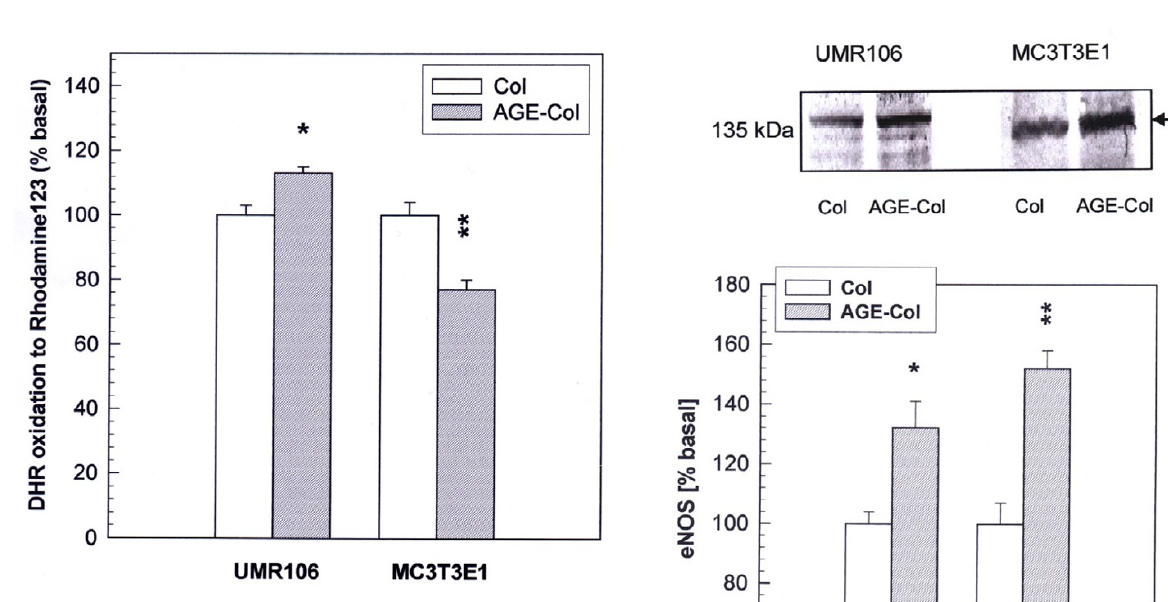
Figure 6 Effect of an AGE-modified type I collagen substratum on the generation of intracellular reactive oxygen species by MC3T3E1 and UMR106 cells. Osteoblasts were cultured at 37 ° C either on control collagen or on AGE-modified colla- gen. After 48 hours, media were replaced by phenol red-free DMEM with 10 µ M dihydro-rhodamine, and cells were incu- bated for an additional 4 hours. At the end of this incubation the cell monolayers were lysated with 0.1 % Triton X-100, and the levels of the oxidation product rhodamine were measured in the lysates by the determination of fluorescence intensity (excitation wavelength 495 nm, emission wave- length 532 nm). Results are given as a percentage of the cor- responding basal condition (unmodified collagen), and are expressed as the mean ± SEM. Differences between collagen vs. AGE-collagen are as follows: * p<0.01; ** p<0.001